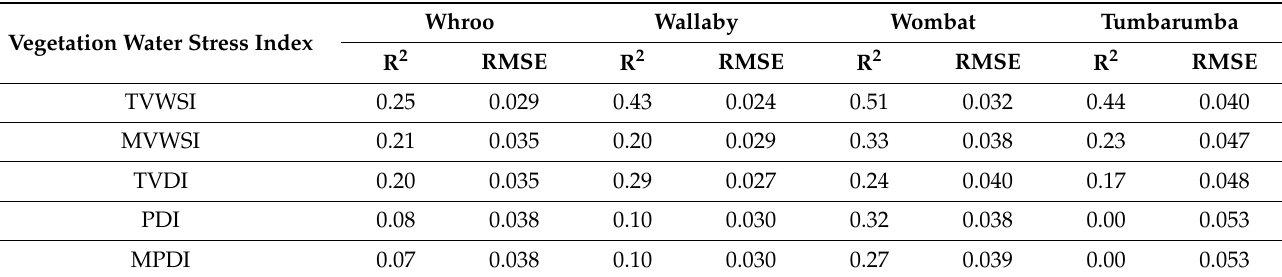
Table 3. R 2 (index vs. soil water fraction) and RMSE (observed vs. predicted Soil Water Fraction) at each of the four FLUXNET sites Whroo, Wallaby, Wombat, and Tumbarumba, corresponding to the 1st-order polynomial function fitted to Soil Water Fraction vs. TVWSI, MVWSI, TVDI, PDI, and MPDI. Vegetation Water Stress